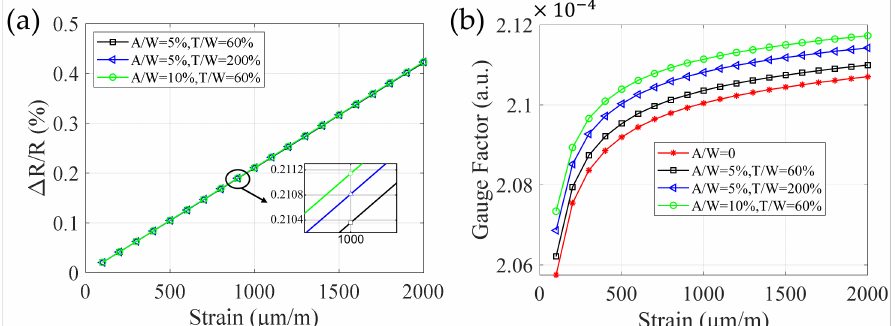
Figure 3. The dependence of RRC and GF on RA and RP in sensitive grids. ( a ) Three susceptible grids with different RA and RP are calculated and increasing RRCs were led by both. ( b )The calculated GFs increase with the strain load in varying RA and RP conditions. Here, an ideal profile with A/W = 0 is used to be the reference for a clear demonstration in ( b ).